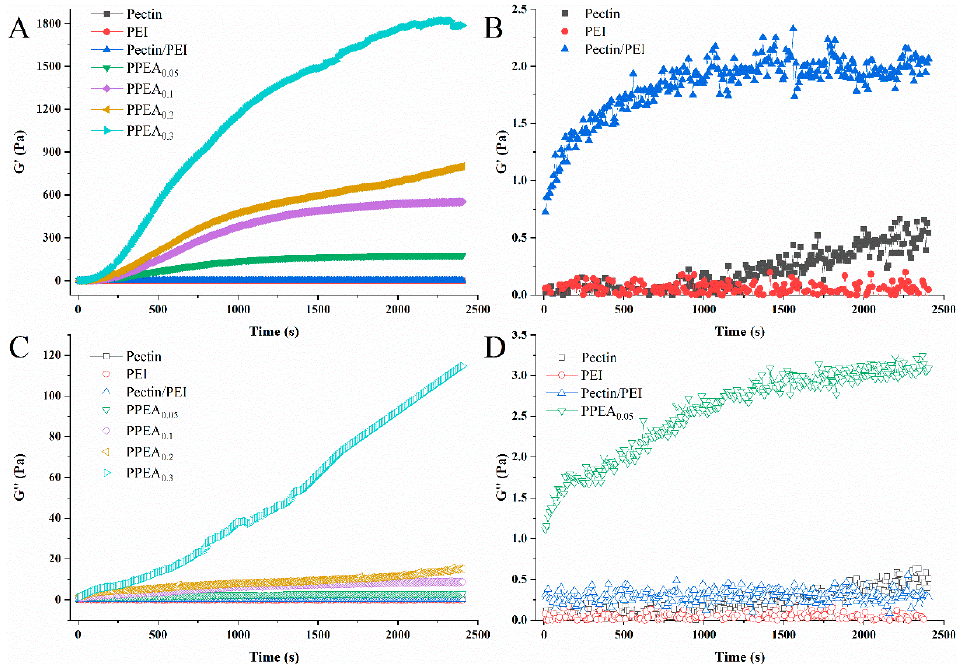
Figure 2. ( A ) Time dependence of the elastic modulus (G ′ ), ( B ) partial enlargement of ( A ), ( C ) loss modulus (G ″ ), and ( D ) partial enlargement of ( C ) for the pectin, PEI, pectin/PEI, and pectin/PEI/EGDE solutions incubated at 60 °C. Table 1. The elemental compositions and degrees of modification ( DM s) of PPEAs.